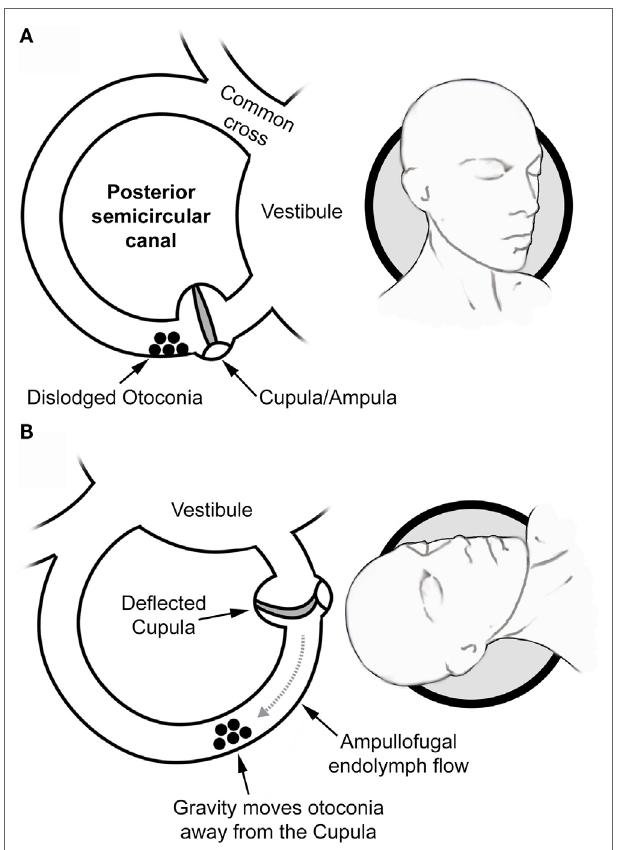
FigUre 2 | Mechanisms in canalolithiasis . (a) With the head in an upright position, a dislodged otoconia is shown in a pc-BPPV patient to be resting within the posterior canal near the cupula region. (B) If the head is first turned 45° toward the affected side and then pulled backward in the plane of the affected canal, gravity induces the otoconia to move downward and thus away from the cupula. This generates ampullofugal endolymph flow, which deflects the cupula away from the vestibule. This triggers an excitatory vestibular afferent signal, which leads to the characteristic nystagmus that is detailed in Figure 3 .